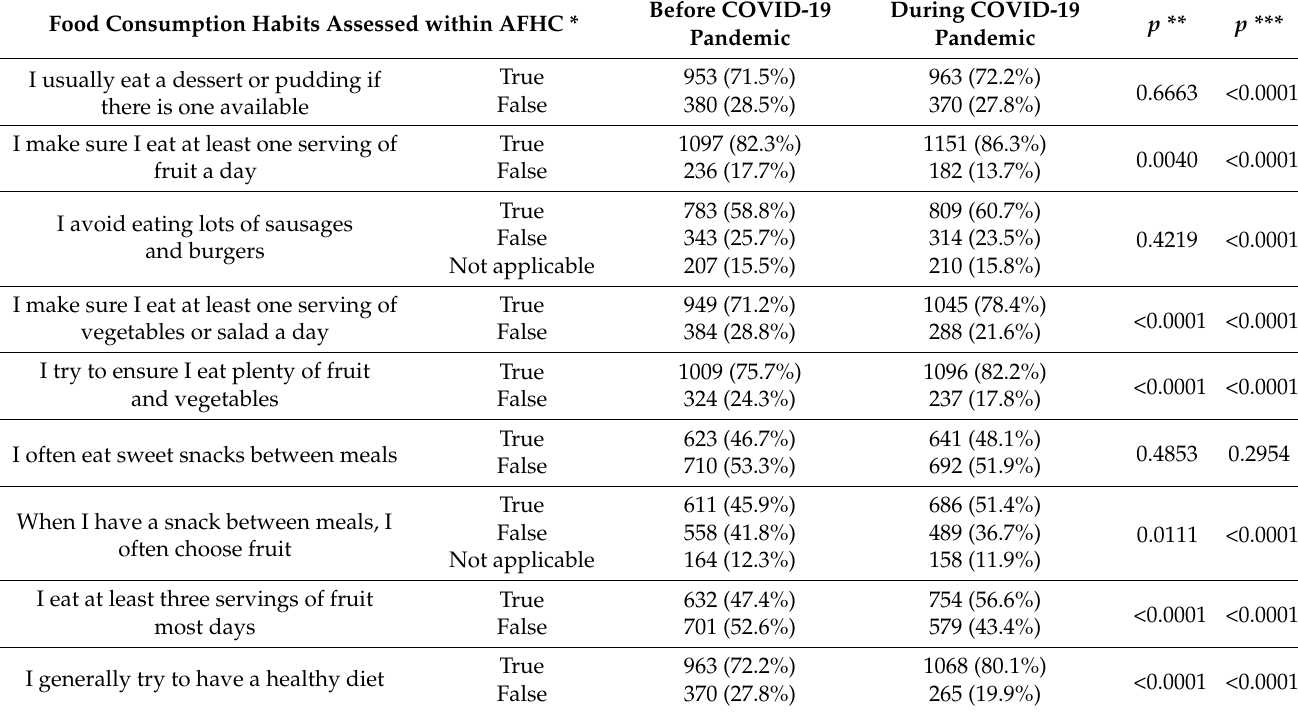
Table 3. The food consumption habits assessed while using Adolescents’ Food Habits Checklist (AFHC) in the period before the COVID-19 pandemic and during the COVID-19 pandemic, as declared by the adolescents from the Diet and Activity of Youth during COVID-19 (DAY-19) Study cohort ( n = 1333).